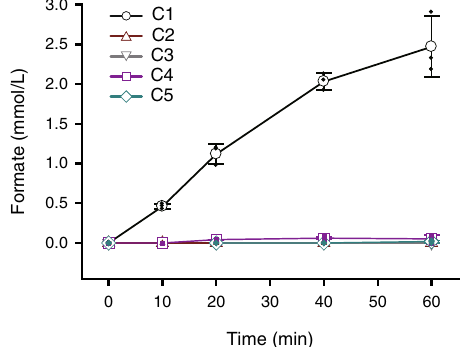
Fig. 3 In vitro formate production by puri fi ed CFOR complex. The formate production was determined using puri fi ed enzyme complex with 2 bar (gauge pressure) of CO/CO 2 (50:50 v/v) or 0.5 bar (gauge pressure) of 100% CO in 50 mM sodium phosphate buffer (pH 7.5). Formate production was determined by HPLC. Symbols indicate 50 ug CFOR with 2 bar of CO/CO 2 (50:50 v/v) gas (C1); 50 ug CFOR with 0.5 bar of 100% CO gas (C2); mixture of 18.3 ug Fdh3 and 31.7 ug Codh with 2 bar of CO/CO 2 (50:50 v/v) gas (C3); mixture of 18.3 ug Fdh3, 31.7 ug Codh, and 198 pmol MV with 2 bar of CO/CO 2 (50:50 v/v) gas (C4); absence of enzyme with 2 bar of CO/CO 2 (50:50 v/v) gas (C5). The data were presented as the average ± SD (open symbol), and all the individual data points were shown (closed symbol). Error bars represent ± SD ( n =